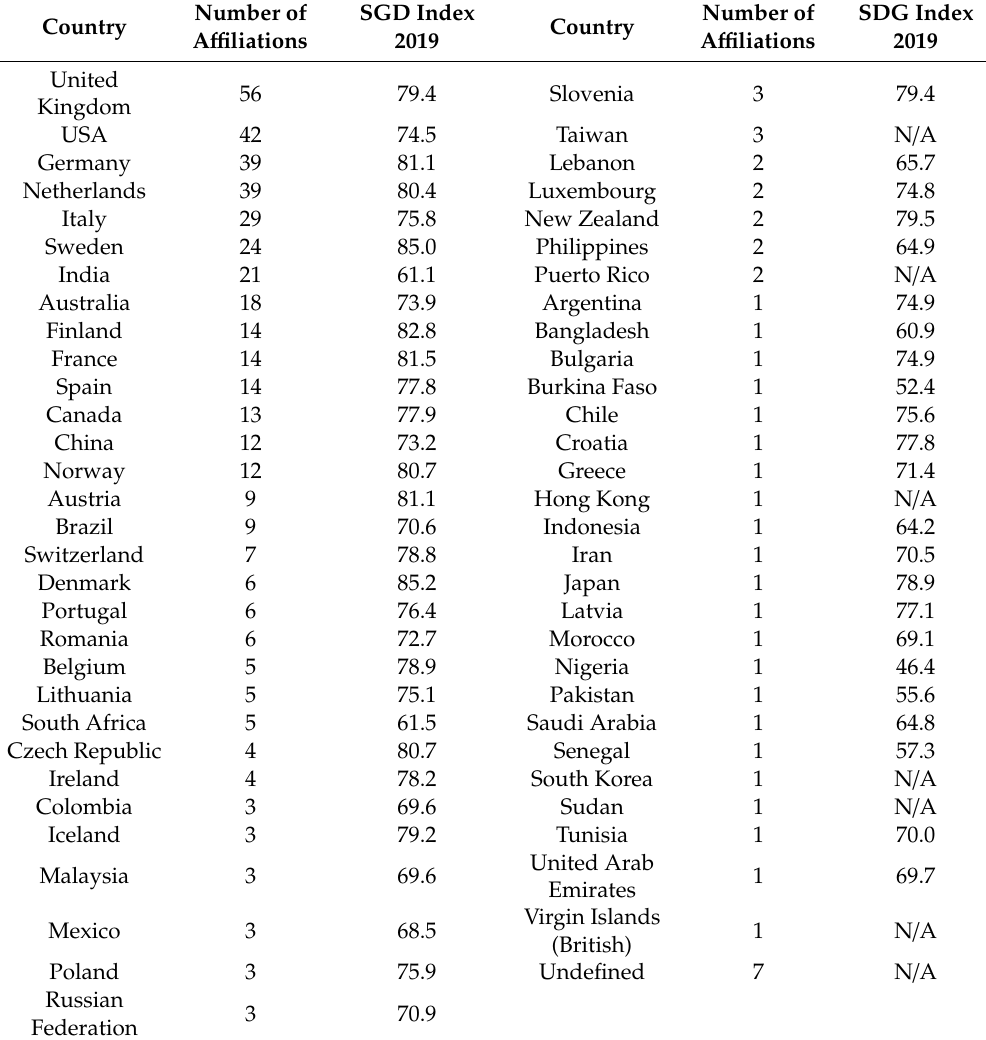
Table 3. Worldwide dispersion of the sustainable business models literature, 2002–2020 ( n = 316).